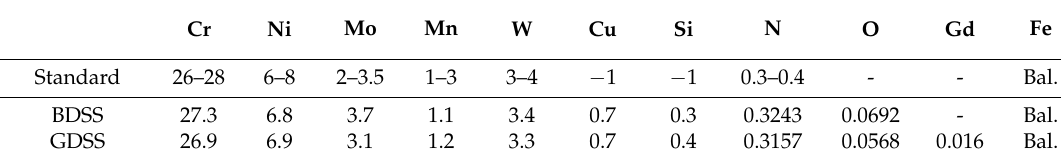
Table 1. Chemical compositions of standard A890 grade 7A duplex stainless steel, BDSS, and GDSS (wt.